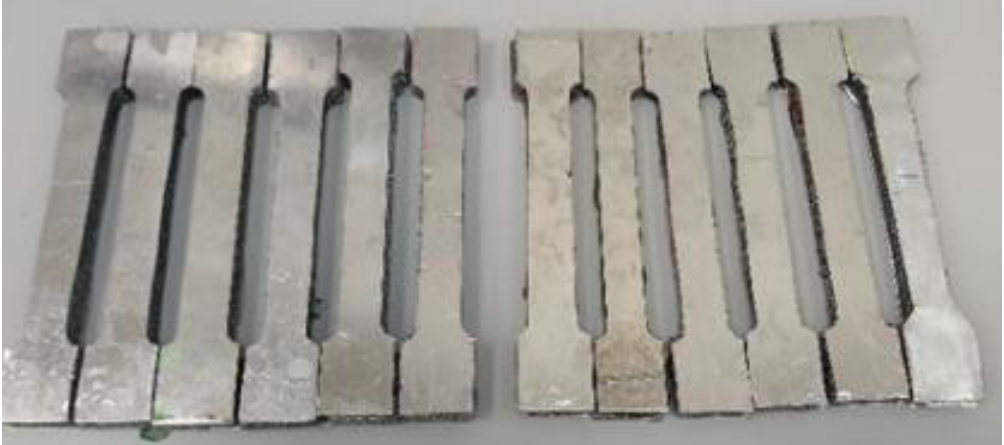
Figure 2: ‘Dog-bone’ AFS specimens